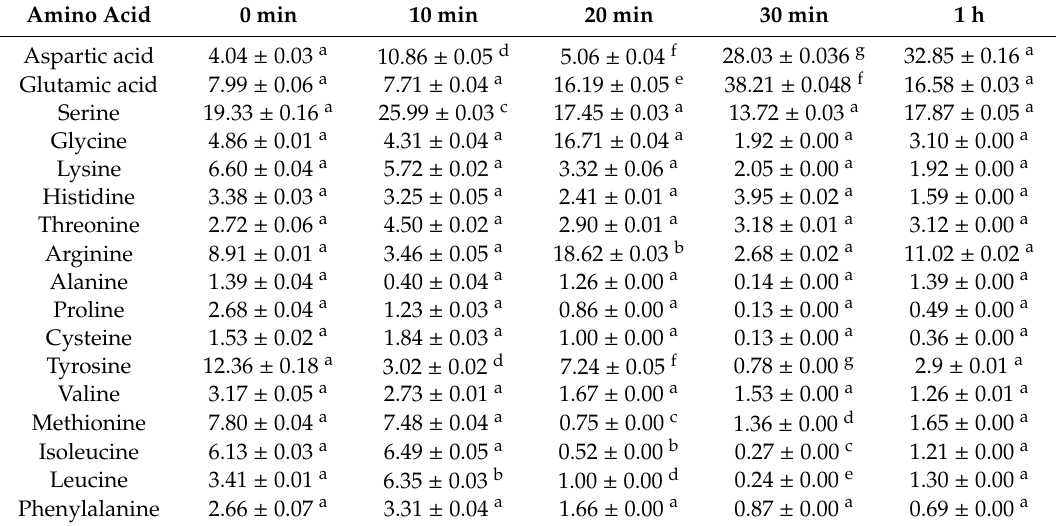
Table 1. Amino acid content (mg of amino acid / g of protein) of hydrolysed collagen as a function of hydrolysis